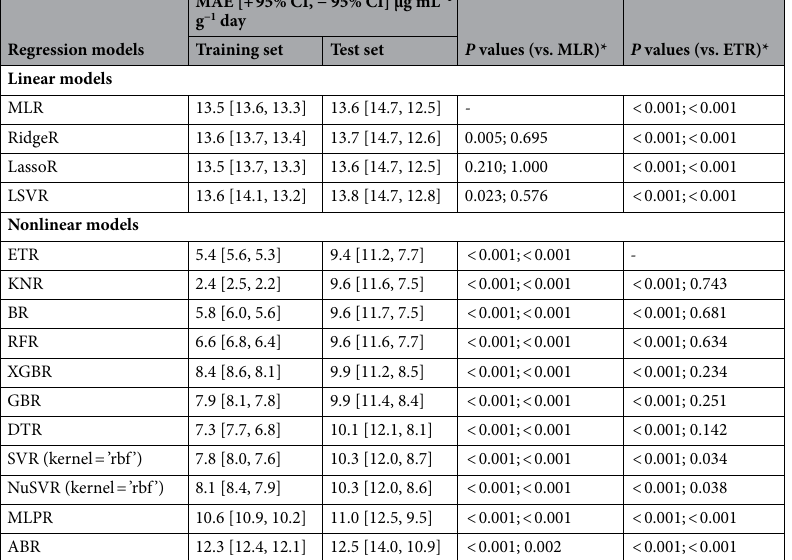
Table S1). Below are the main parameters that were optimized for our final ETR model: (1) ’n_estimators’: 31; (2) ’max_depth’: 20; (3) ’min_samples_leaf’: 1; (4) ’min_samples_split’: 6; and (5) ’max_features’: ’auto’. We then compared the predictive performance of the ETR model before and after feature selection and parameter adjustment on the derivation cohort. The optimal ETR model enhanced generalization by reducing the overfitting yielded a lower MAE on the test set (not statistically significant, P = 0.106), but obtained a higher MAE on the training set (statistically significant, P < 0.001) than the ETR model before optimization.